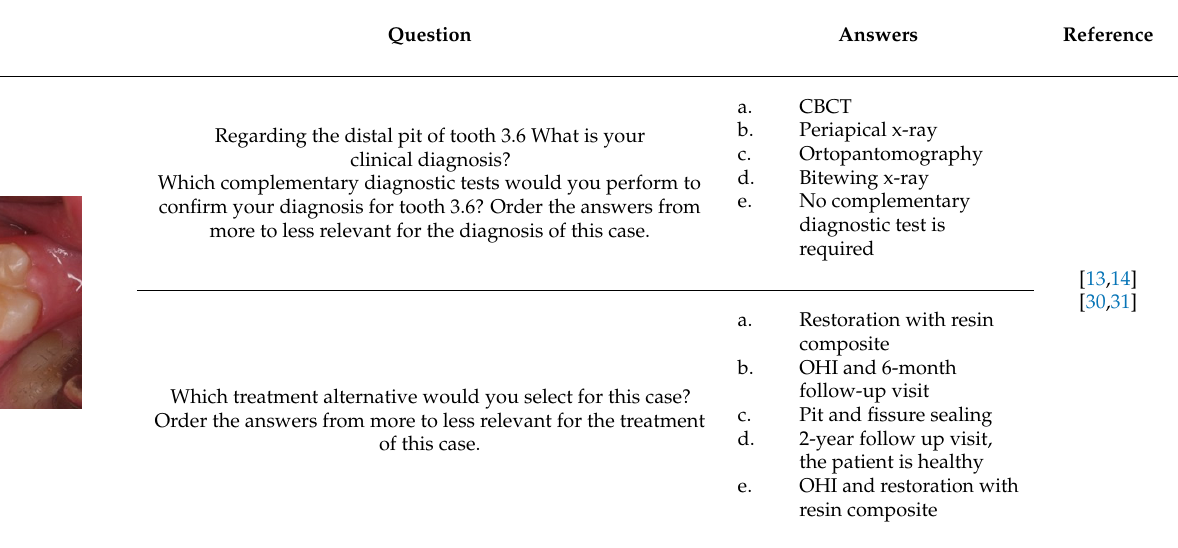
Table 1. Clinical scenarios and references from the scientific evidence consulted for each case.